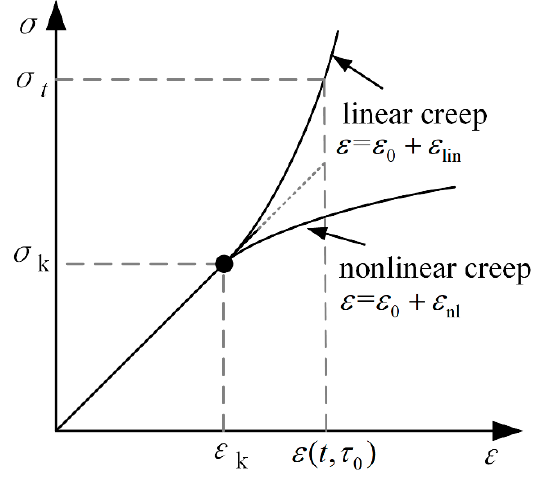
Figure 3. Creep development curve of concrete with stress.